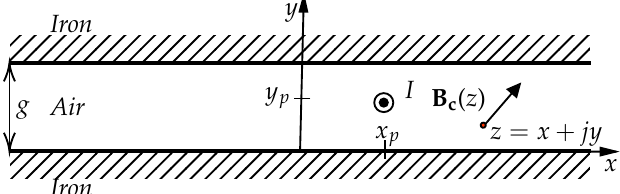
Figure 1. Conductor powered by a current I , flowing outwards the paper plane, between two smooth infinitely permeable iron surfaces, in the complex